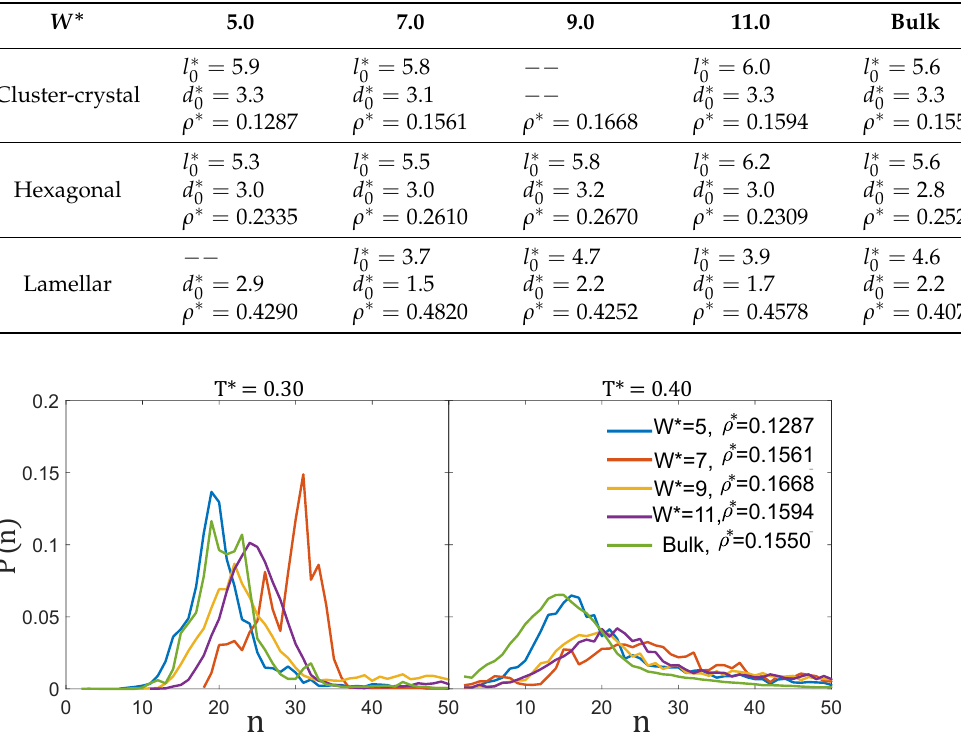
Figure 4. Cluster-size distributions of the cluster-crystal in bulk and in the slit pores of width W ∗ at T ∗ = 0.3 and T ∗ =